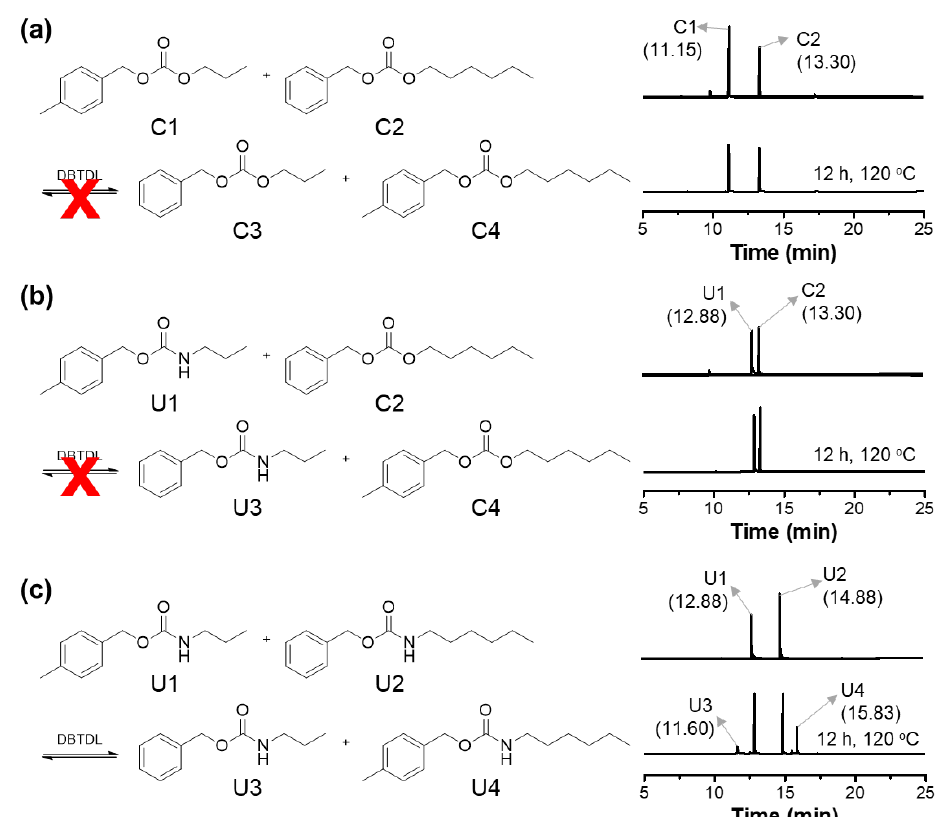
Figure 4. GC analyses during the exchange reactions (transcarbonation or transcarbamoylation) using the model compounds. ( a ) Exchange between carbonates (C1 + C2), resulting in no reaction. ( b ) Exchange between the carbonate and carbamate (U1 + C2), showing no change. ( c ) Exchange between carbamates (U1 + U2), and the appearance of new carbamates (U3 and U4).